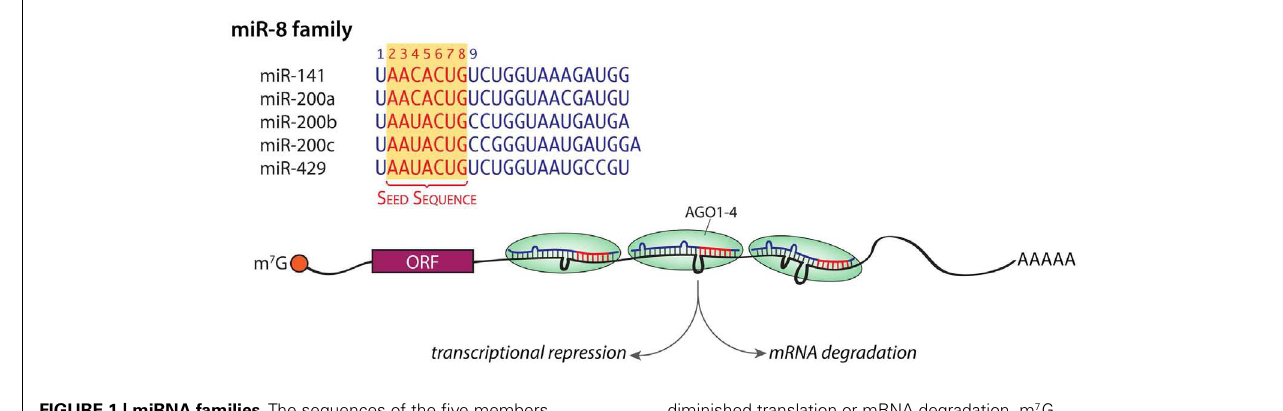
FIGURE 1 | miRNA families. The sequences of the five members of the miR-8 family are shown; the shared seed sequences are shown in red. An mRNA with RISC bound to three different loci in its 3 (cid:48) -UTR is shown; the net effect of these interactions can be